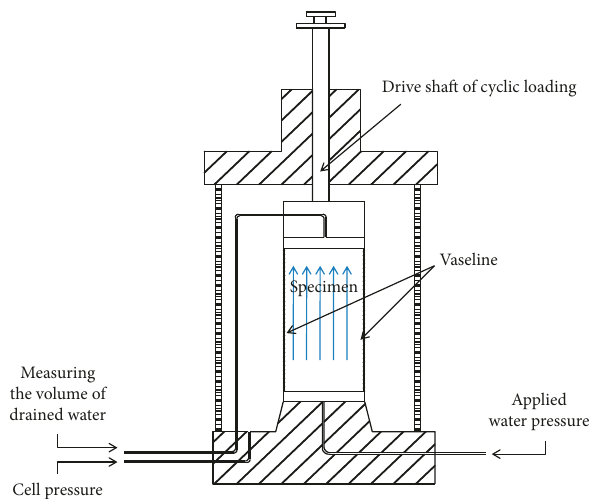
Figure 6: Principle of forming seepage flow in the specimen.